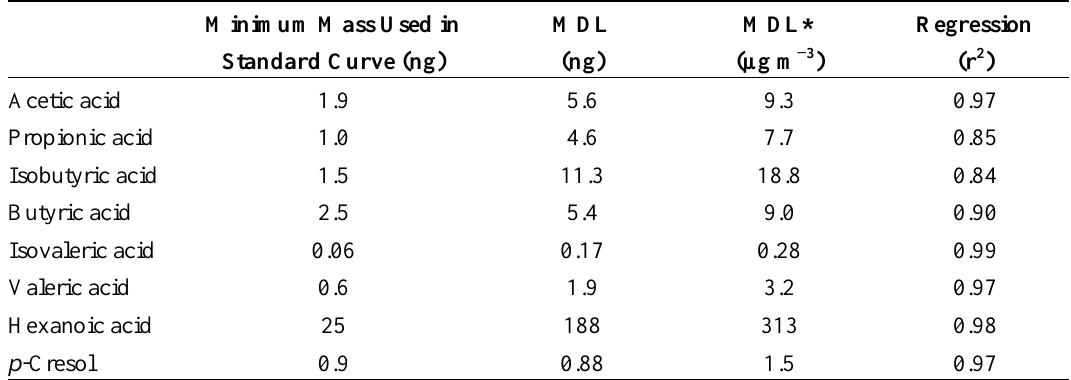
Table 1. Minimum mass, method detection limits, and coefficient of determination statistics for the standard